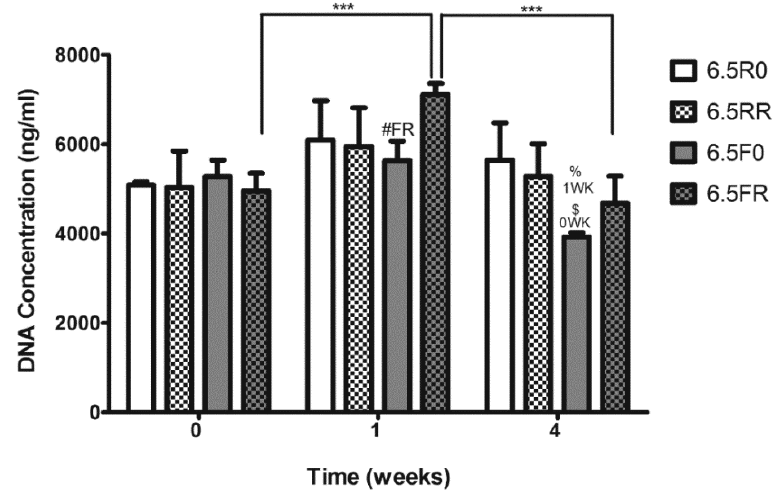
Figure 7. DNA quantification of ATDC5 cells encapsulated inside 6.5% ( w / v ) PEG hydrogels varying in the cross-linker type (F or R) and RGD content, and cultured over time in 4C chondrogenic